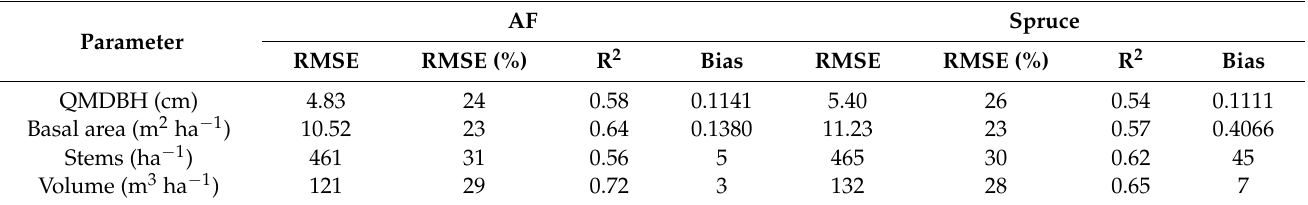
Table 7. Weighted k -NN modelling results for all field plots (AF) and only using majority Spruce field plots (Spruce). AF Spruce Parameter RMSE Bias Bias